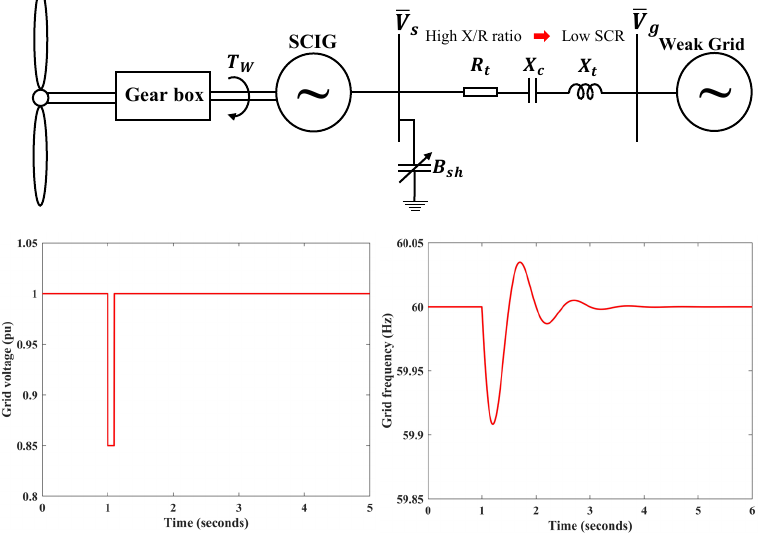
Figure 1. Single line diagram of the WT-SCIG system with variations in grid voltage and